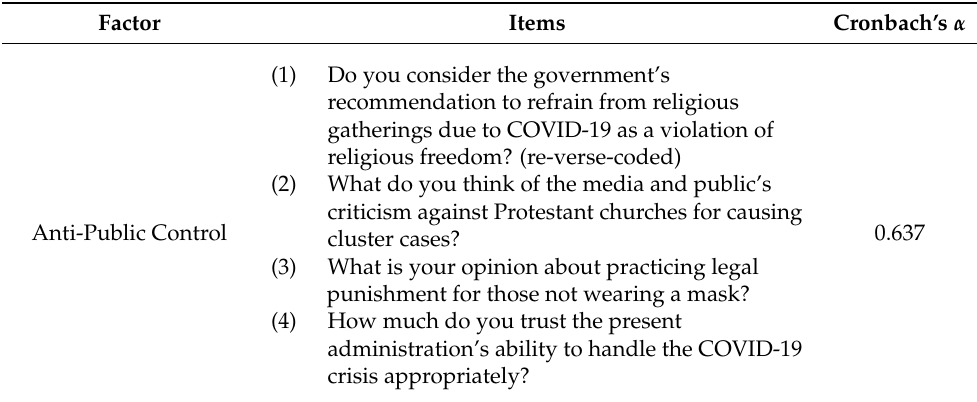
Table 8. Item contents of anti-public control.